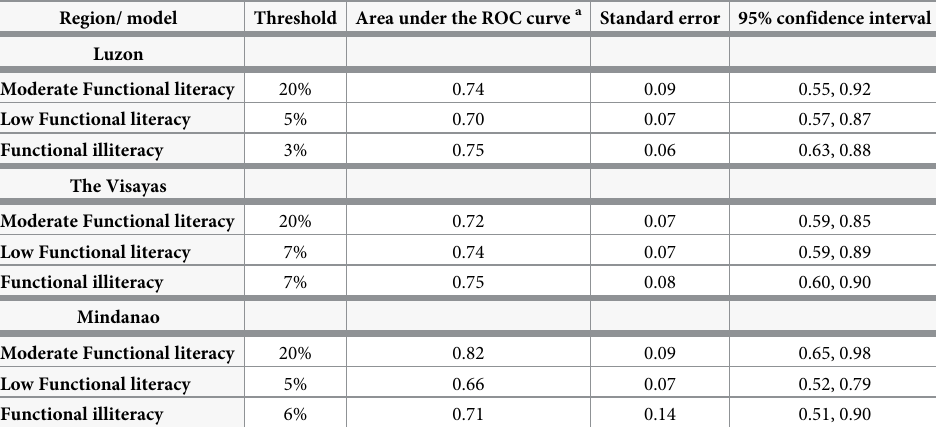
Table 9. Area under the receiver operating characteristic (ROC).